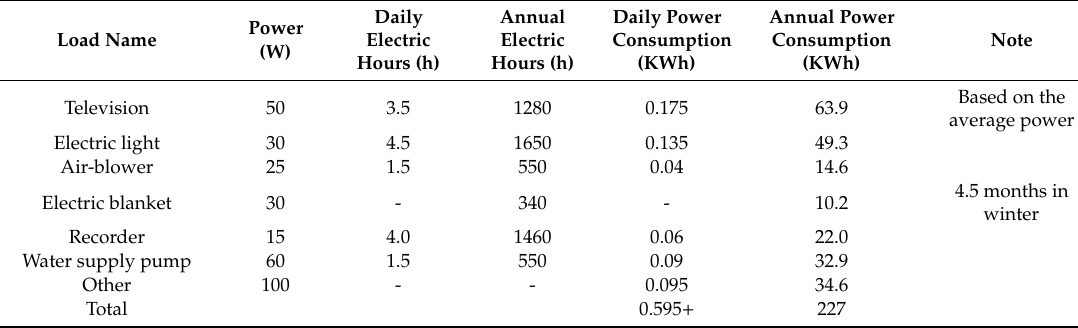
Table 3. Electric power consumption of household appliances.